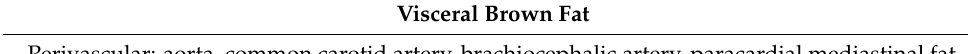
Table 1. Topography of brown adipose tissue. From: [9] (reproduced with permission).